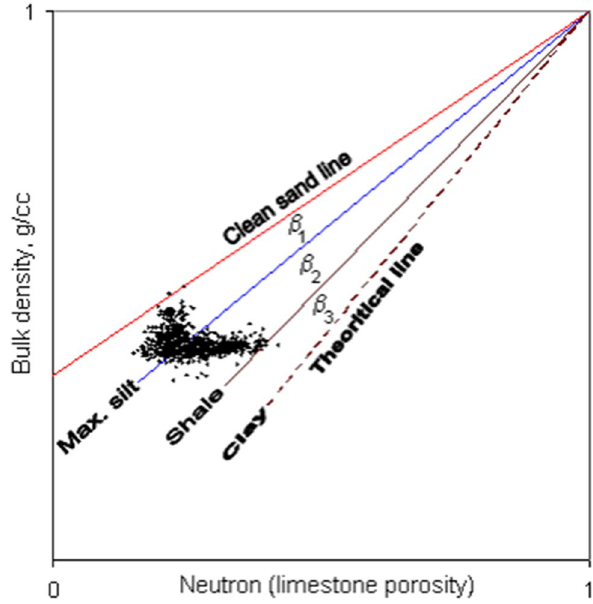
Fig. 2 Lithology model for sand, silt and clay identification, and quantification using density–neutron log data (Choo